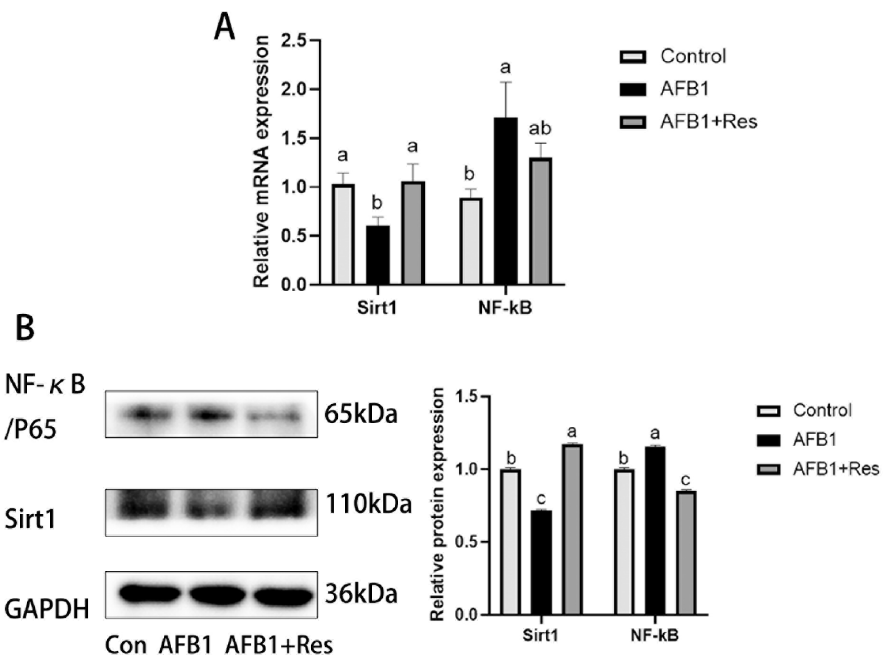
Figure 8. Effect of Res on the expression levels of Sirt1 and NF- κ B in duck liver exposed to AFB1 . Values are represented as the mean ± SEM ( n = 6). a–c Mean values with same superscript letters or no letters within a row were of no significant difference ( p > 0.05), those with different superscript letters were of significant or extremely significant difference ( p < 0.05). ( A ) mRNA levels of Sirt1 and NF- κ B genes. ( B ) protein levels of Sirt1 and NF- κ B genes.